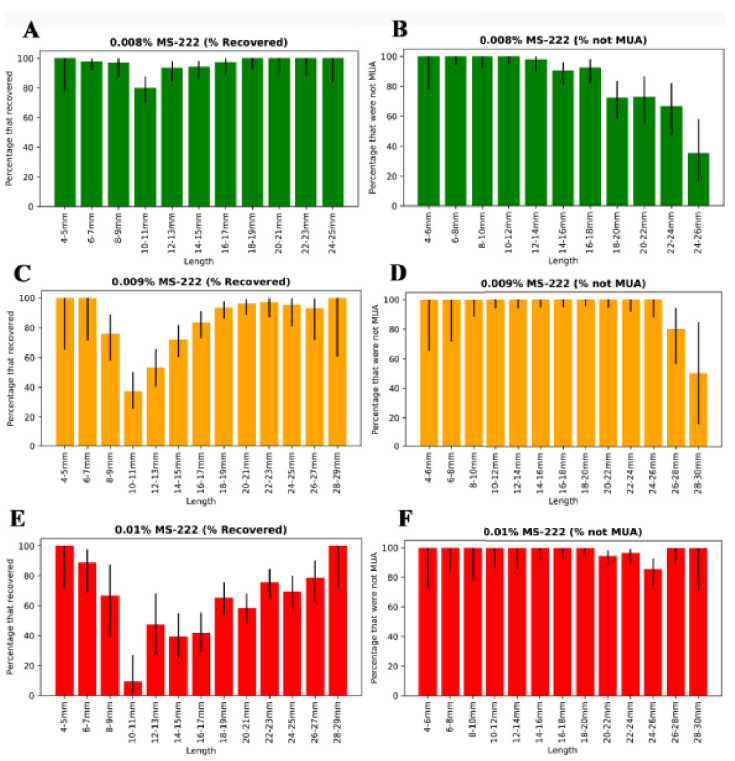
Fig 2. Metamorphic fish become sensitive to MS-222 around 10mm SL and later become de-sensitised around 24mm SL. (A), (C), (E) Percentage of fish that recovered by length for concentrations of 0.008%, 0.009% and 0.01% MS-222 respectively. (B), (D), (F) Percentage of fish that were not MUA for concentrations of 0.008%, 0.009% and 0.01% MS-222 respectively. Black lines represent the 90% confidence interval for each value, calculated using the sample size (see materials and